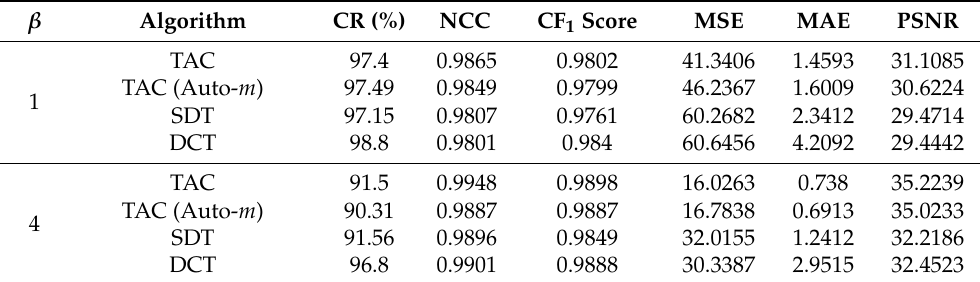
Table 4. Compression results: Dataset